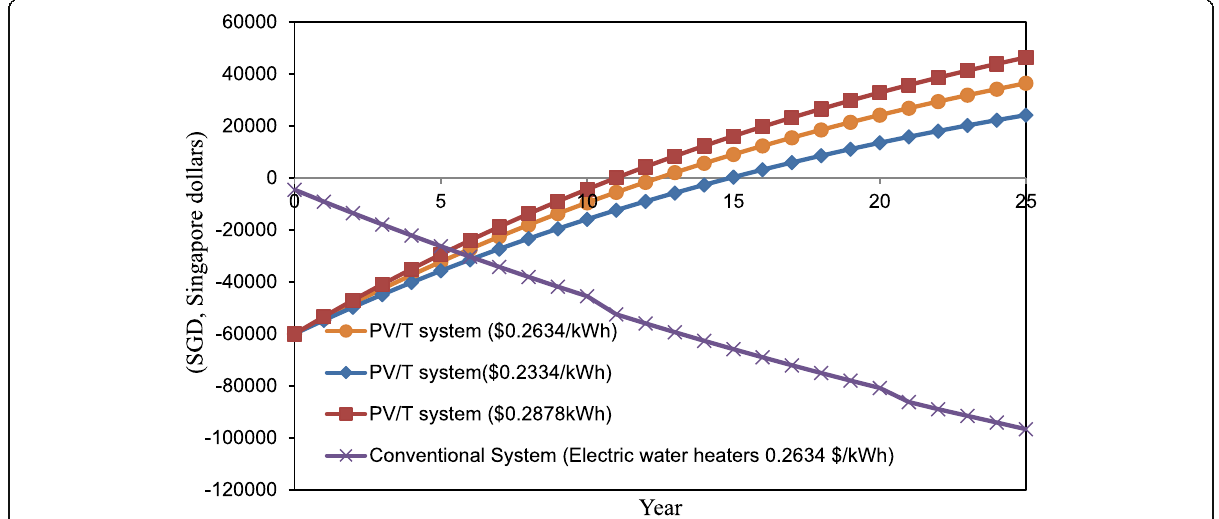
Fig. 9 Cumulative cash flow variation of a PVT system and a conventional water heater system with time for various electricity